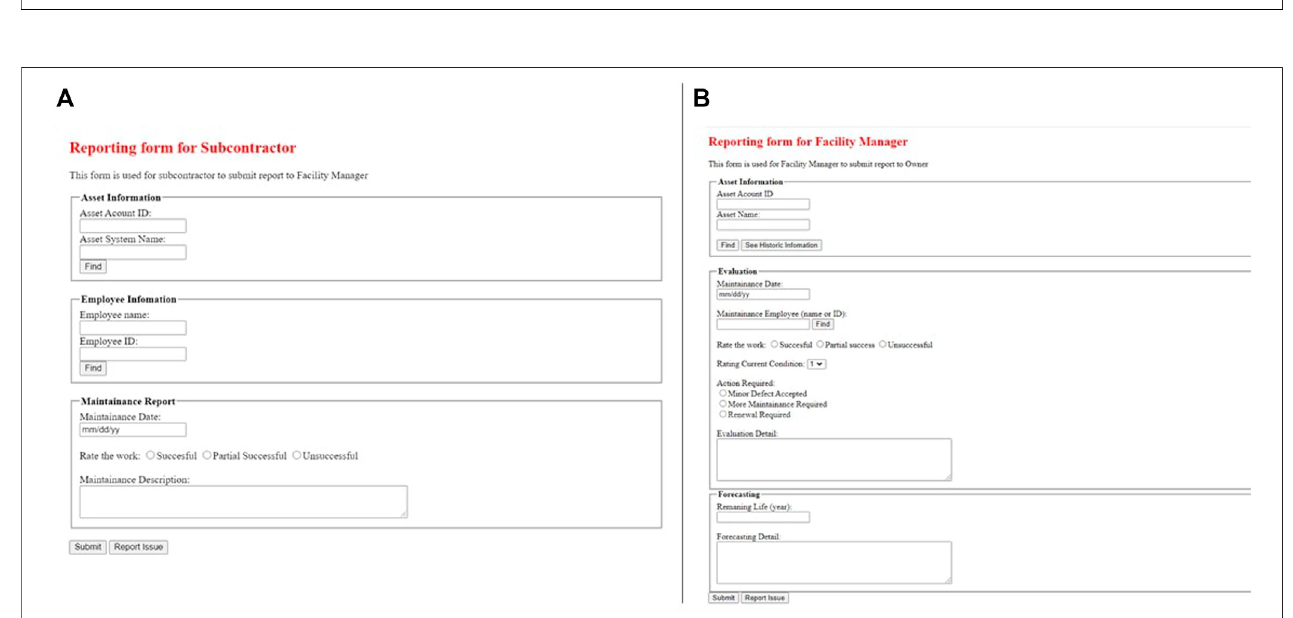
FIGURE 14 | Report form for Subcontractor (A) and for Facility Manager (B) .